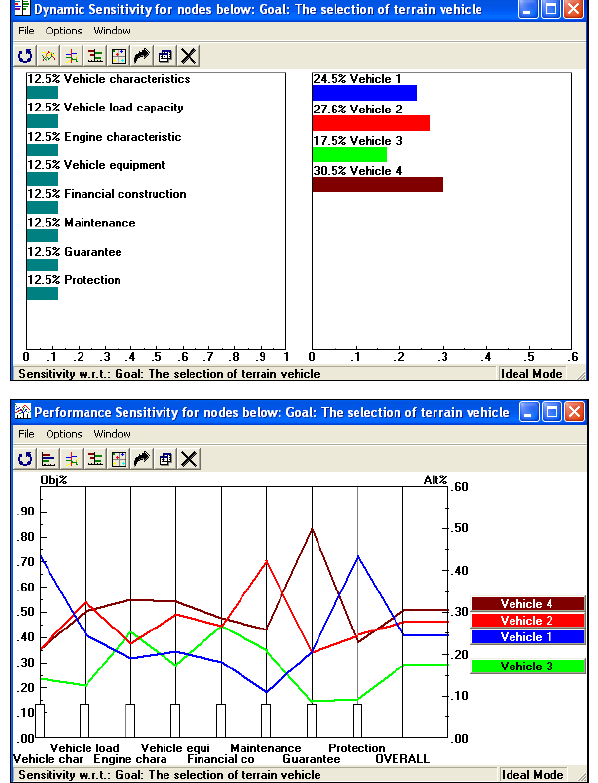
Figure 14. All the criteria have the same weights